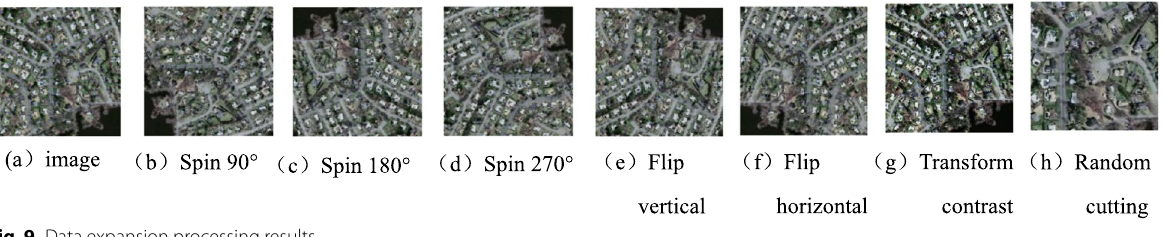
Fig. 9 Data expansion processing